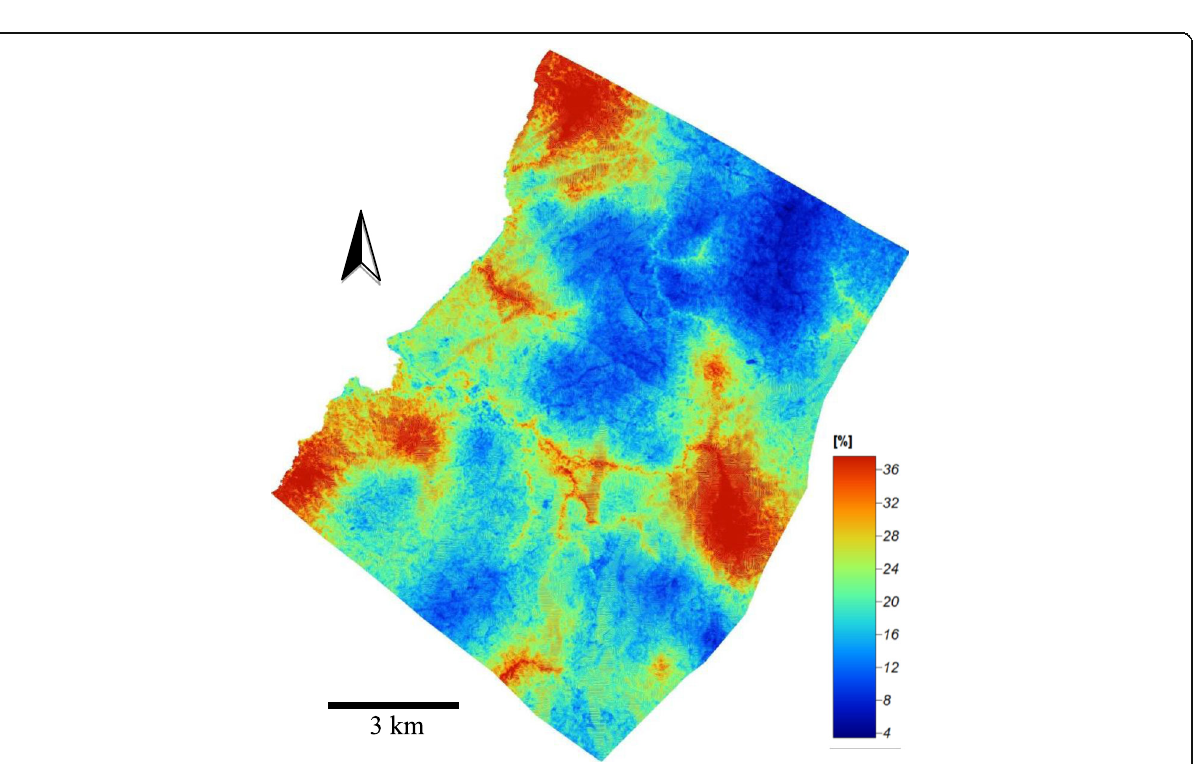
Fig. 10 Final Model of Sand after back transformation